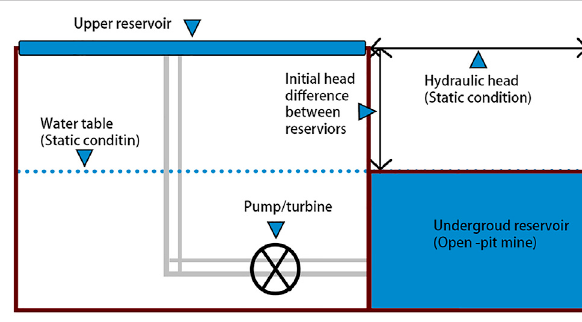
FIGURE 2 | The cross section diagram of PHES of abandoned open-pit mine (redrawn from Pujades).